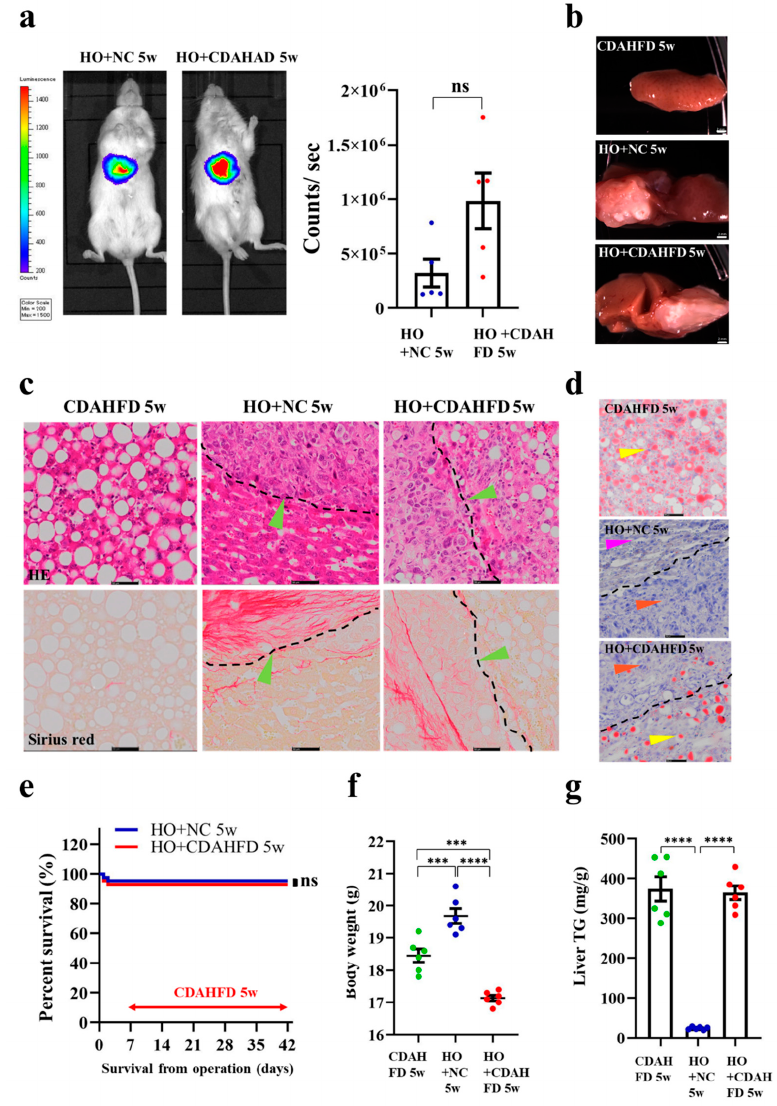
Figure 5. Implantation of HCC organoid to the liver with NAFLD TME. ( a ) Bioluminescence imaging that shows luciferase signal in mice fed with or without CDAHFD. Bioluminescence signal is illustrated in pseudo color. Mann–Whitney U test ( n = 5/group). ( b ) Images of liver tissues. Top to bottom: liver tissue from mice fed with CDAHFD 5 weeks only, liver tissues from mice implanted with HCC organoid fed with NC (HO + NC 5 weeks), liver tissues from mice implanted with HCC organoid and fed with CDAHFD (HO + CDAHFD 5 weeks). Scale bar represents 2 mm. ( c ) HE staining and Sirius staining of mice liver in the following different groups: fed CDAHFD 5 weeks only (left top panel), HO + NC 5 weeks (middle top panel), HO + CDAHFD 5 weeks (right top panel). The black dotted line indicates the junction of liver tissue and tumor tissue. The bottom panel shows the Sirius red staining result. Green arrows indicate tumor cells. The scale bar represents 50 μ m. ( d ) The figure shows the ORO staining of mice liver in the following different groups: fed CDAHFD 5 weeks only (top), implanted HO + NC 5 weeks (middle), implanted HO + fed CDAHFD 5 weeks (bottom). The black dotted line indicates the junction of liver tissue and tumor tissue. Orange arrows indicate tumor cells, yellow arrows indicate NAFLD cells, purple arrows indicate normal liver cells. The scale bar represents 50 µ m. ( e ) The survival rate of HO + NC 5 weeks and HO + CDAHFD 5 weeks. Log-rank test, n = 12. ( f ) Body weight of the mice. One-way ANOVA followed by Tukey’s multiple comparisons test ( n = 6/group). ( g ) Liver TG. One-way ANOVA followed by Tukey’s multiple comparisons test ( n = 6/group). *** p < 0.001, **** p < 0.0001; ns: not